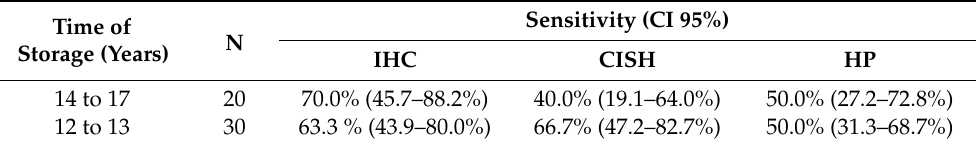
Table 2. Sensitivity for the detection of amastigote forms found by IHC, CISH, and HP according to the time of storage of 50 paraffin blocks from patients with new world cutaneous leishmaniasis caused by L. ( V. ) braziliensis .